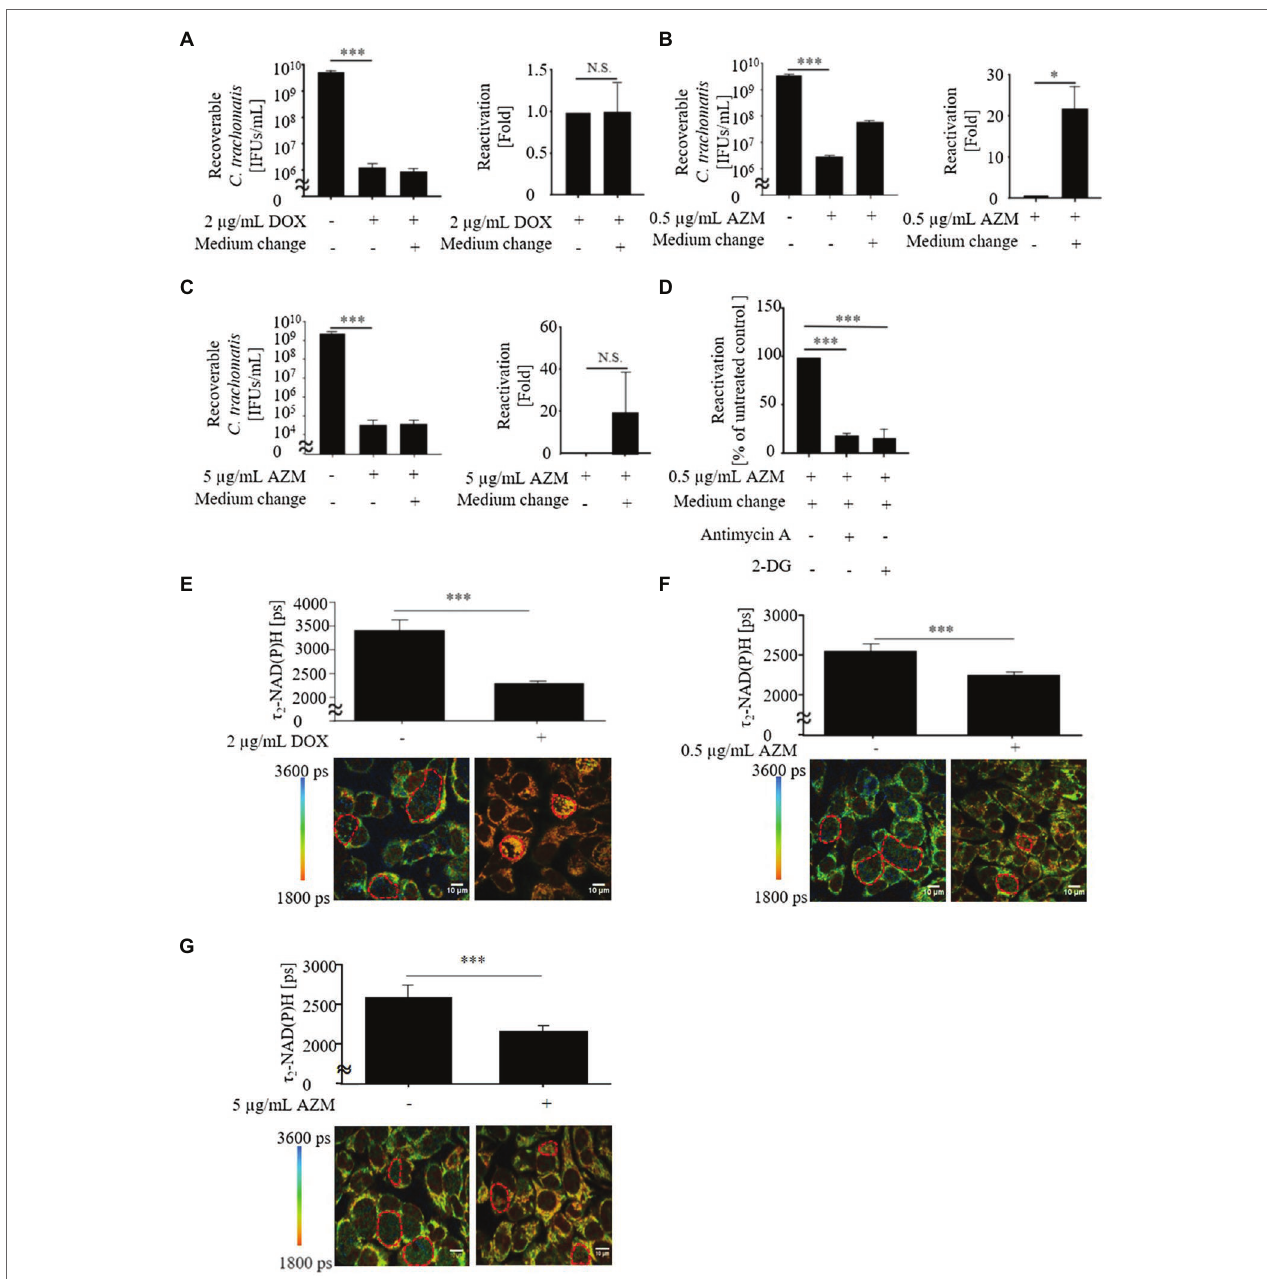
FIGURE 1 | Viability and metabolic activity of Chlamydia trachomatis in HeLa cells after treatment with 2 μ g/ml of doxycycline (DOX), 0.5 or 5 μ g/ml of azithromycin (AZM). (A) Recoverable C. trachomatis after treatment with 2 μ g/ml of DOX for 24 h and reactivation of C. trachomatis after medium change. (B) Recoverable C. trachomatis after treatment with 0.5 μ g/ml of AZM for 24 h and reactivation of C. trachomatis after medium change. (C) Recoverable C. trachomatis after treatment with 5 μ g/ml of AZM for 24 h and reactivation of C. trachomatis after medium change. (D) Reactivation with 3 mM of 2-DG or 0.2 μ M of antimycin A. (E) Upper panel: Quantitative analysis of τ 2 -NAD(P)H signals in the chlamydial inclusions. Bottom panel: Color-coded images of τ 2 -NAD(P)H in chlamydial inclusions in the presence or absence of 2 μ g/ml of DOX 44 hours post infection (hpi). (F) Upper panel: Quantitative analysis of τ 2 -NAD(P)H signals in the chlamydial inclusions. Bottom panel: Color-coded images of τ 2 -NAD(P)H in chlamydial inclusions in the presence or absence of 0.5 μ g/ml of AZM 44 hpi. (G) Upper panel: Quantitative analysis of τ 2 -NAD(P)H signals in the chlamydial inclusions. Bottom panel: Color-coded images of τ 2 -NAD(P)H in chlamydial inclusions in the presence or absence of 5 μ g/ml of AZM 44 hpi. Ct , C. trachomatis ; DOX, doxycycline; AZM, azithromycin; 2-DG, 2-deoxyglucose ( A-D : n = 3, E-G : ROIs; Mean ± SEM, Student t -Test and Sidak’s multiple comparison: * p ≤ 0.05; *** p ≤ 0.001; and N.S., not